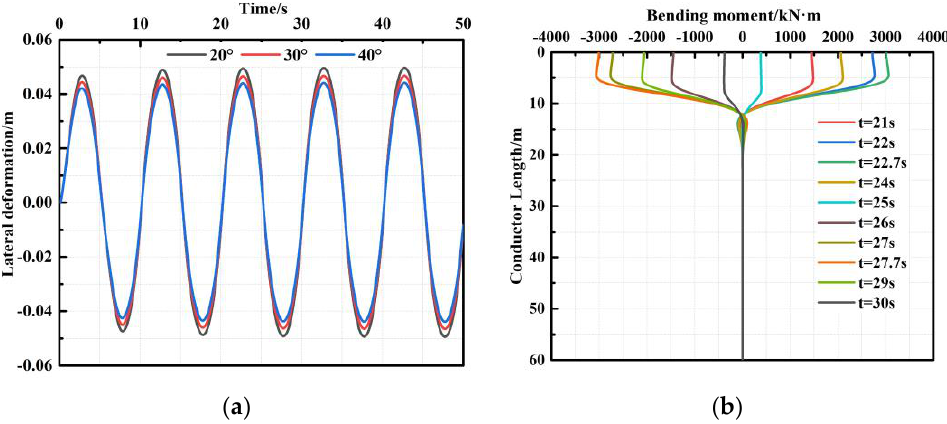
Figure 16. The influence of the internal friction angle on the mechanical response of the conductor, where ( a ) is the variation of the lateral moment at the top of the conductor with time and ( b ) is the variation of the bending moment along the conductor axial direction when the internal friction angle is 40°.